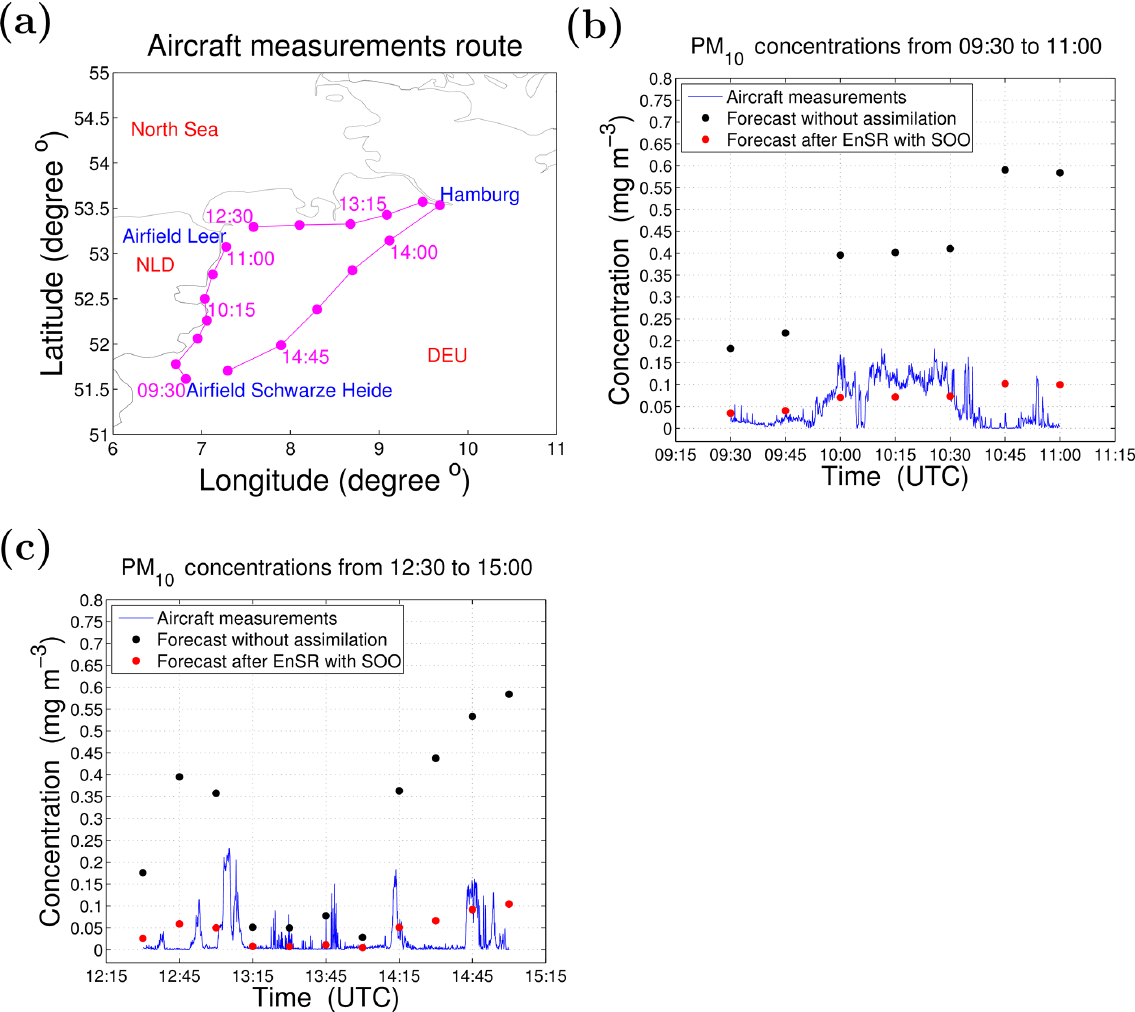
Figure 9. Evaluation of effective assimilation forecasts using aircraft measurements (18 May 2010). (a) Aircraft measurements route. (b) Comparisons of measurements, forecasts after assimilation (ensemble mean) or without assimilation from 09:30 to 11:00UTC. (c) Com- parisons from 12:30 to